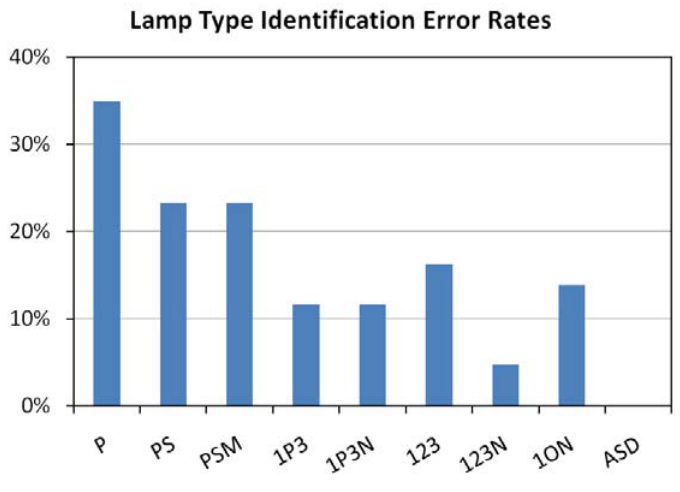
Figure 18. Error rates for the identification of nine types of